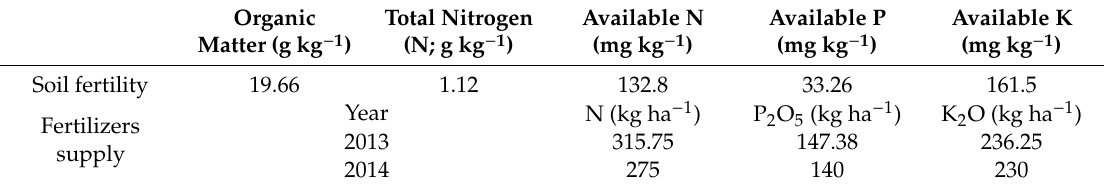
Table 1. The mean soil fertility in 0–20 cm layer and fertilizers supply in the experimental